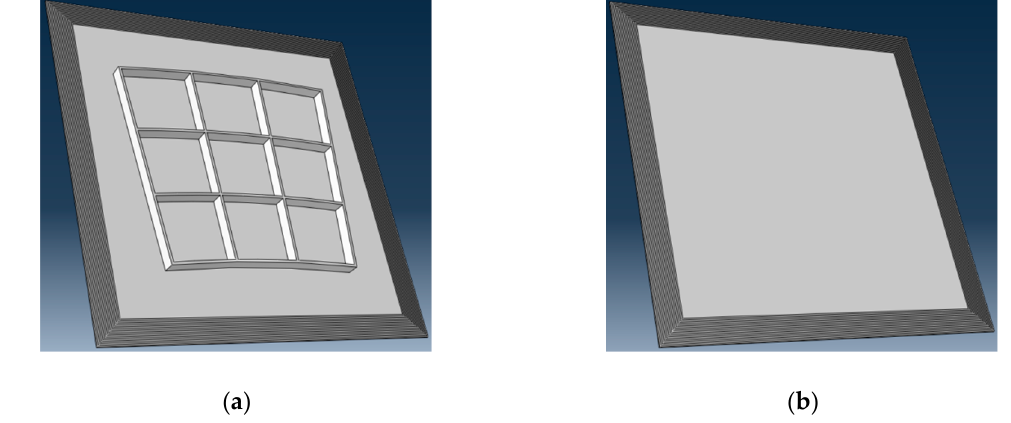
Figure 6. Three-dimensional finite element simulation model: ( a ) sti ff ened panel; ( b ) flat panel. Figure 6. Three ‐ dimensional finite element simulation model: ( a ) stiffened panel; ( b ) flat panel.